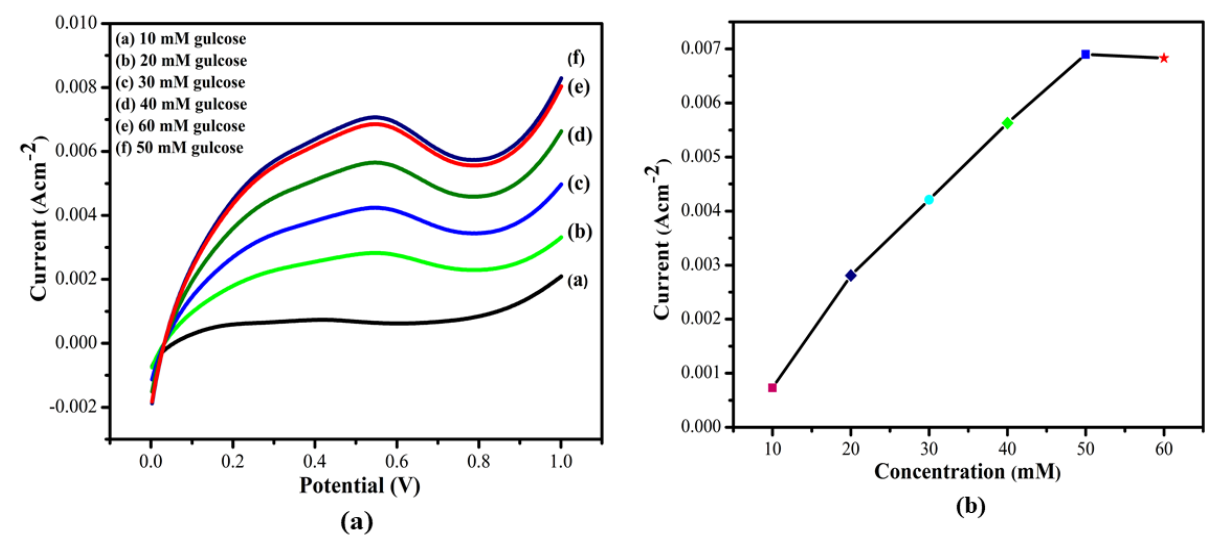
Figure 12. ( a ) Linear sweep voltammogram of GCE/(MWCNT/ZnS/AgNWs/PANI/Frt/GOx by increasing glucose range (10–60 mM) in PBS pH. 7.0 at ambient temperature. ( b ) The calibration curve of current densities observed in the glucose concentration ranged from 10–60 mM.